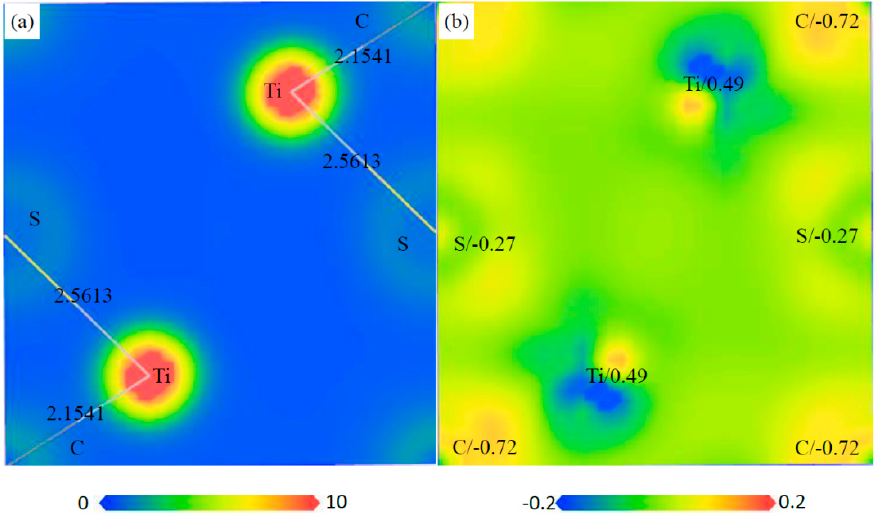
Figure 11. Electron density maps of the (110) plane in Ti 2 S 2 , ( a ) total electron density map from 0 to 10 (e/Å 3 ) and the bond length (Å), ( b ) electron density difference map (e/Å 3 ) and the atomic populations (e).